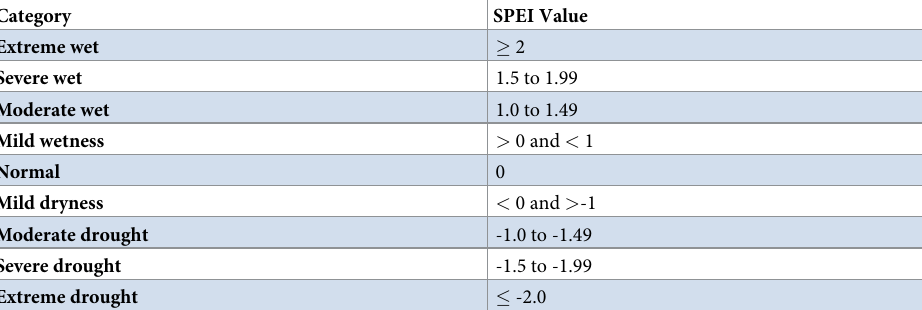
Table 1. Drought and wet categories based on SPEI